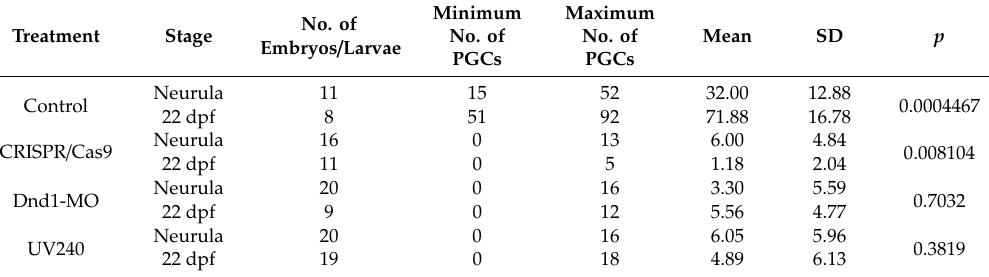
Table 2. Comparison of CRISPR / Cas9, Dnd1 -MO and UV240 methods.